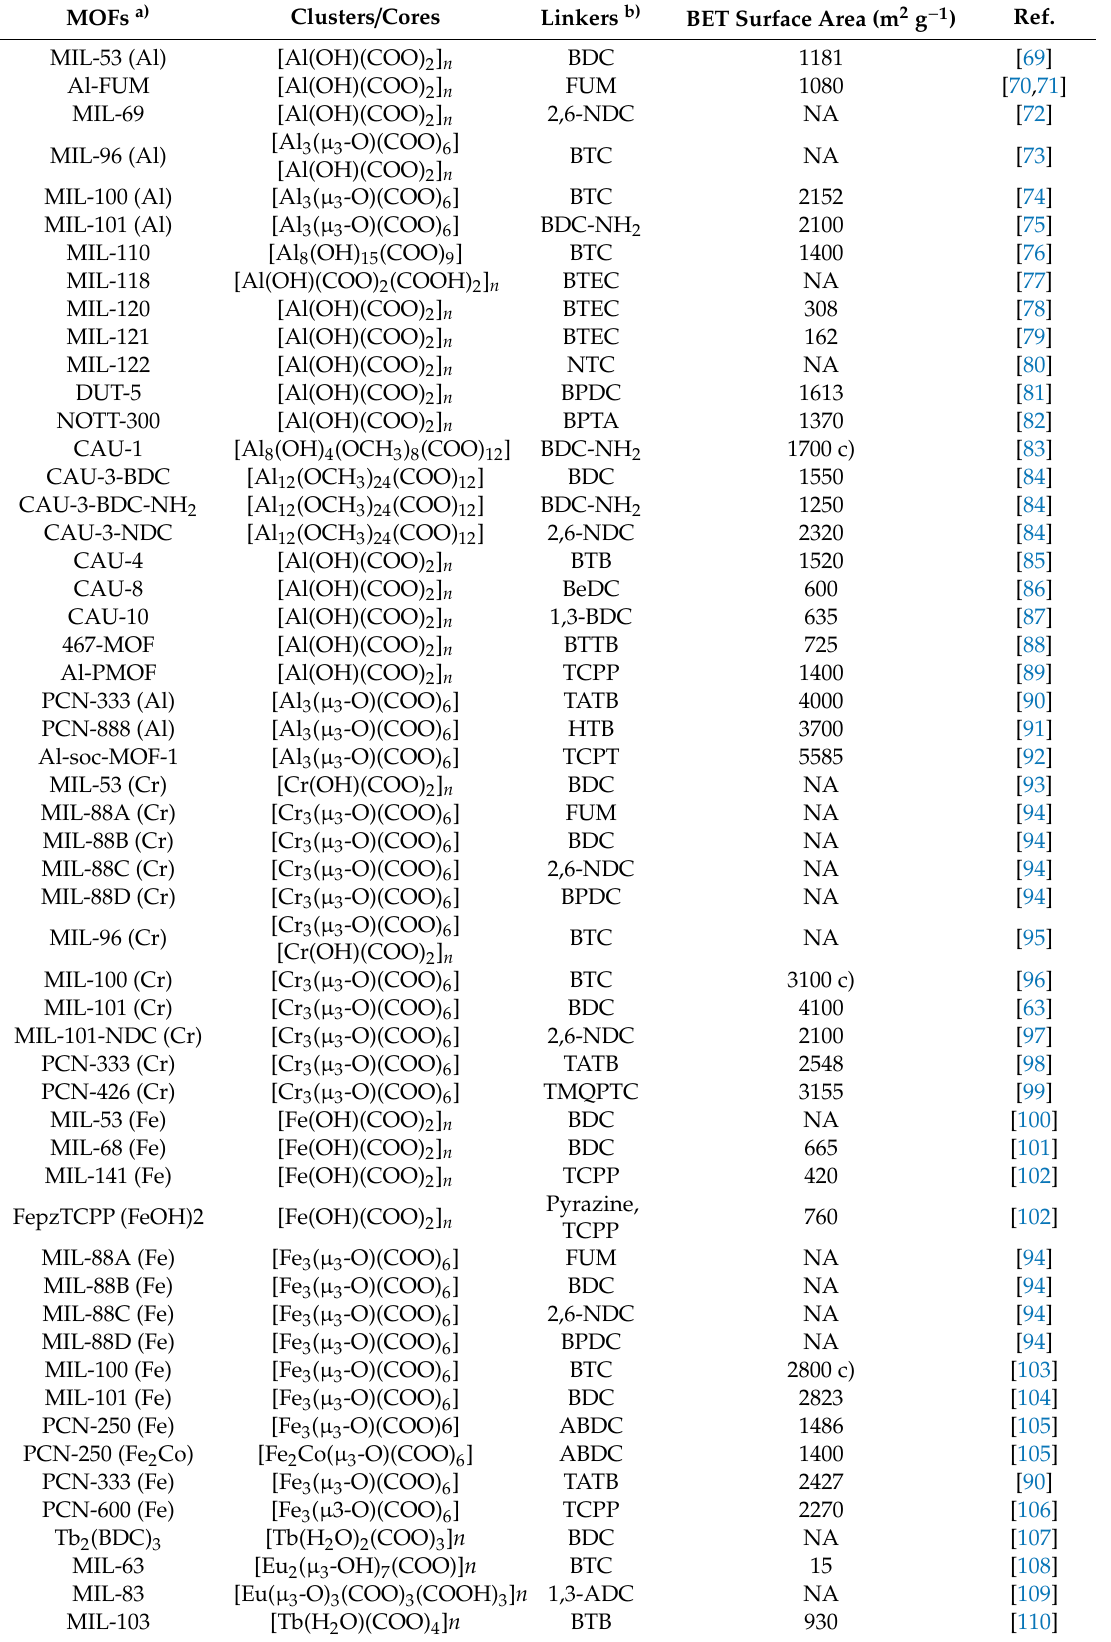
Table 1. Abridgment of some stable MOFs